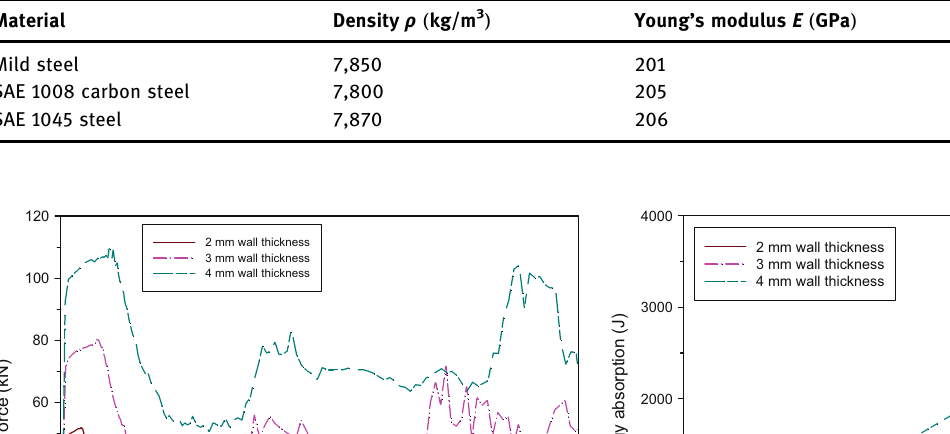
Figure 11: Force versus displacement curve generated during axial loading with three di ff erent wall thicknesses.